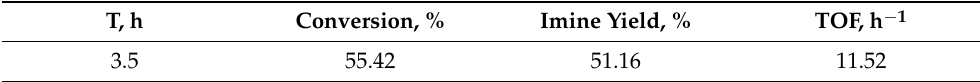
Figure 12. Condensation of acetophenone and aniline over Au@meso-UiO-66 nanocatalyst into imine. Acetophenone:aniline molar ratio is 1:2. 1 . Yield; 2 . Conversion. Furthermore, the condensation of acetophenone and aniline could impact the imine yield increase in the second catalytic cycle over the Au@meso-UiO-66 nanohybrid without a remarkable change in conversion values. 3. Discussion The obtained results show that using Au-containing hierarchically structured meso- UiO-66 and meso-NH 2 -UiO-66 nanomaterials, a high phenylacetylene conversion and imine yield are achieved (Table 2). It is suggested that the enhanced catalytic performances of the Au@meso-UiO-66 and Au@meso-NH 2 -UiO-66 nanohybrids are based on a combination of a number of factors. The first of them is their extremely small crystallite nanosizes, which are below ~8–14 nm. This high dispersion of the carrier nanoparticles could be assigned to the utilization of the MW-activation of the reaction mass for the synthesis of the meso-UiO-66 and meso-NH 2 - UiO-66 host matrices. Actually, the MW technique is a well-recognized method for pro- ducing inorganic and hybrid materials [70] including UiO-66-type matrices with a high dispersion of the nanoparticles forming them [43,71,72]. 0%10% 20% 30%